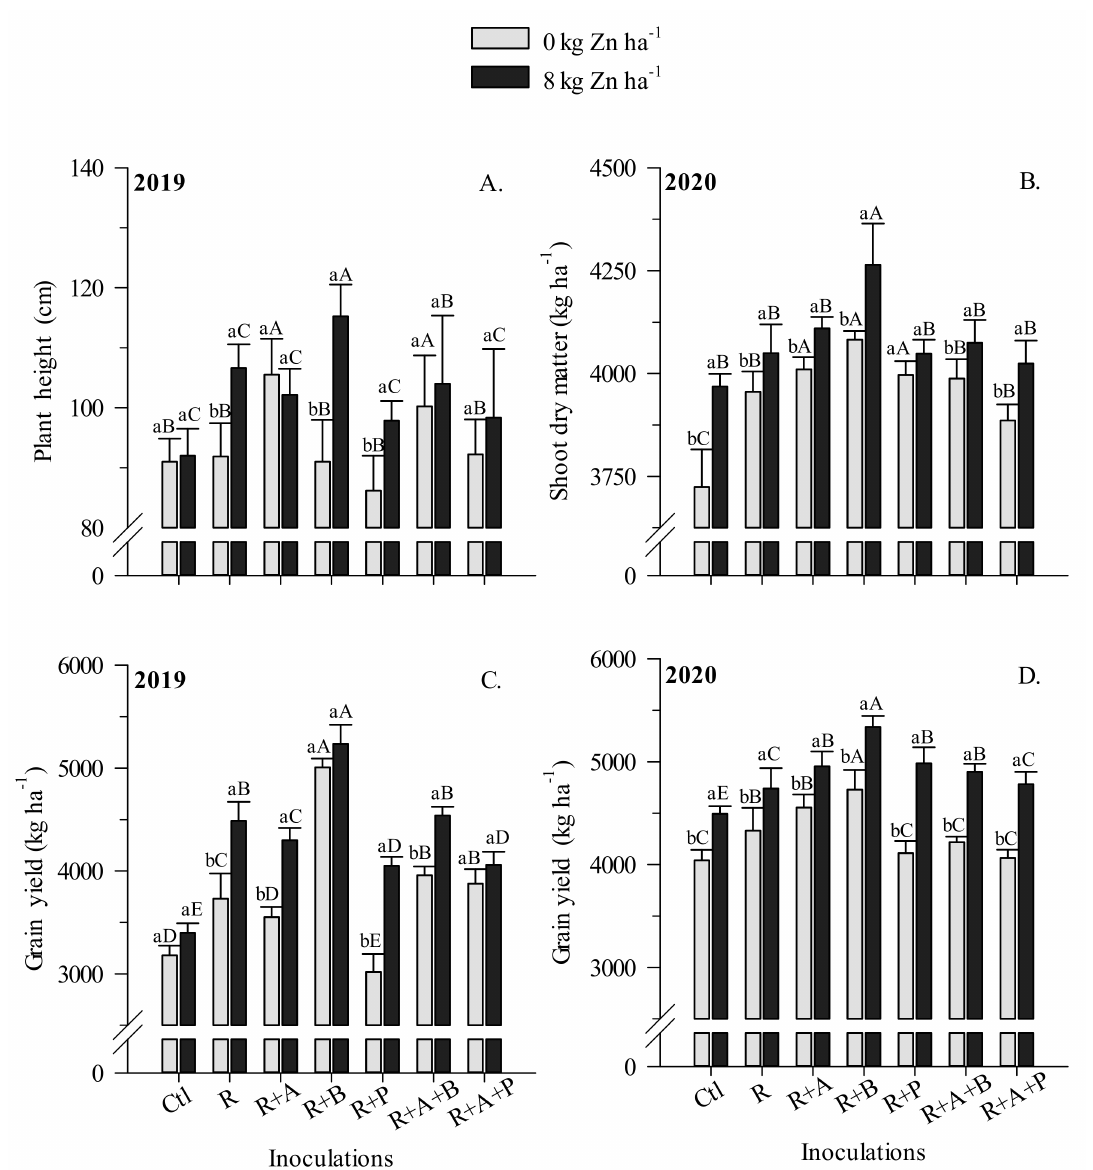
Figure 4. The influence of soil Zn and co-inoculations on common bean growth attributes and grain yield: ( A ) Plant height (cm) in 2019; ( B ) Shoot dry matter (kg ha − 1 ) in 2020; ( C , D ) Grain yield (kg ha − 1 ) in 2019 and 2020, respectively. Ctl (No inoculation); R ( R. tropici ); R + A ( R. tropici + A. brasilense ); R + B ( R. tropici + B. subtilis ); R + P ( R. tropici + P. fluorescens ); R + A + B ( R. tropici + A. brasilense + B. subtilis ); and R + A + P ( R. tropici + A. brasilense + P. fluorescens ). The uppercase letters are used for inoculation interactions within each level of soil Zn application, whereas lowercase letters are used for the unfolding of Zn levels within each inoculation treatment. The identical alphabetic letters do not differ from each other, as analyzed by Tukey (Zn application; p < 0.05) and Scott–Knott (inoculations; p < 0.05) tests for 2019 and 2020, respectively. Error bars indicate the standard error of the mean (n = 4 replications). Selv í ria, 2019 and